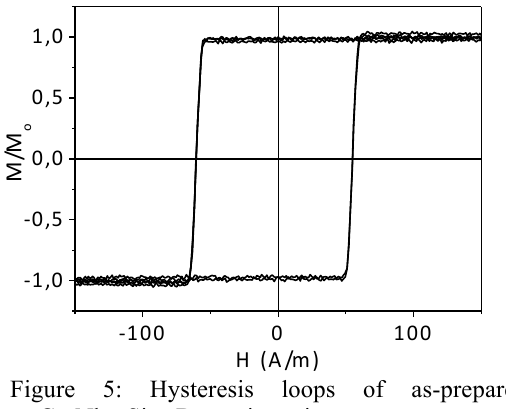
Figure 7: Coercivity dependence on annealing temperature measured in Fe microwire with ρ =0.6